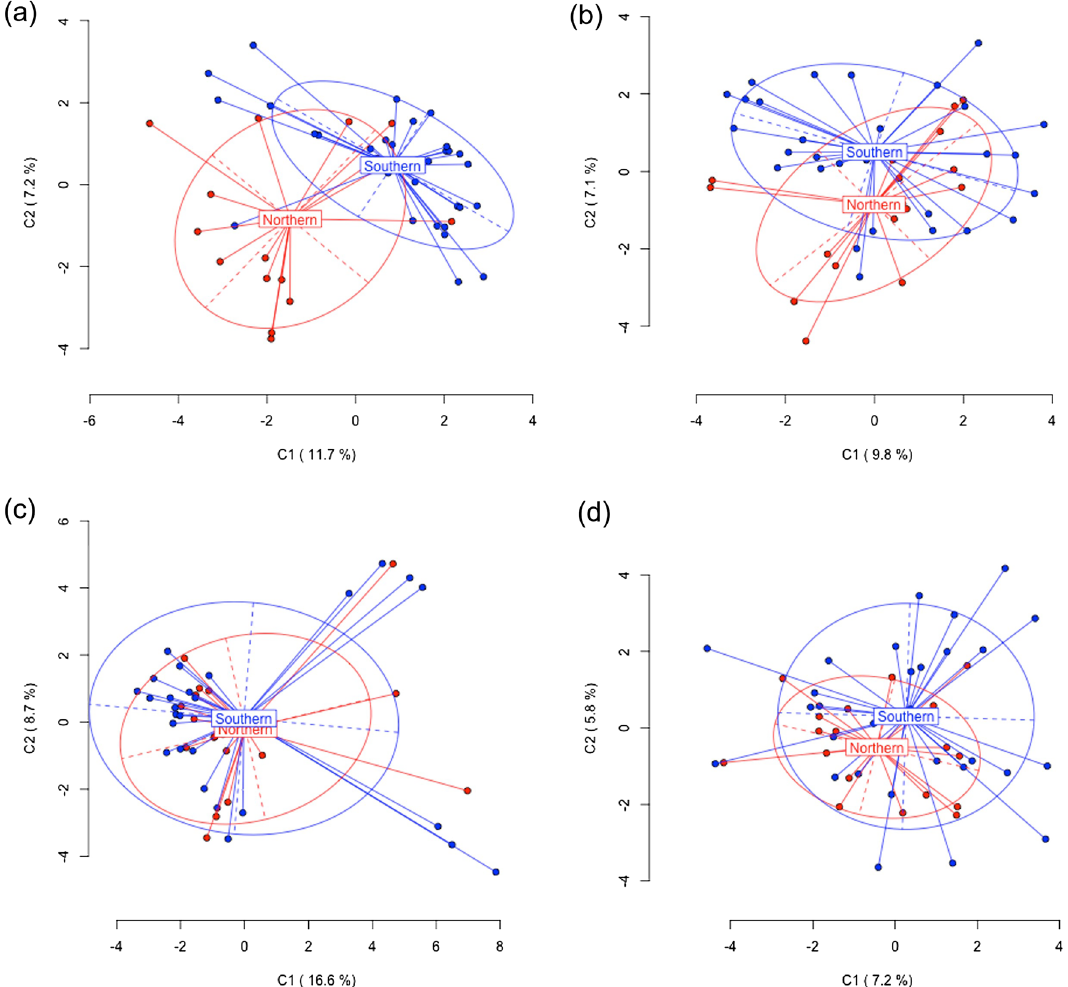
Figure 4. Results from principal coordinate analysis (PCoA) for epigenetic (MSL) of separated tissue (Muscle, Gonad, Gill) and eggs for the two regions (Southern and Northern), after AMOVA results based on hypothesis 2 (see “Material and methods”). The first two coordinates (C1 and C2) are displayed with the indication of the percentage of variance explained in brackets. Scores represent individual samples. Group labels show the centroid for each group (i.e. region). Ellipses represent the average dispersion of those points around the centroid. The long-dashed axis of the ellipse shows the direction of maximum dispersion, and the short-dashed axis shows the direction of minimum dispersion. ( a ) Eggs; ( b ) Gonad; ( c ) Muscle; ( d ) sites, different studies have shown that macroalgae grow faster and attain larger biomass in association with the upwelling sites off Central Chile 28,29 . Moreover, kelp forests are resilient to nutrient loading from freshwater discharges and may experience enhanced productivity when stimulated by nitrogen runoff 37 . Therefore, food supply could be associated with this trend of potential increasing eggs lipid metabolism along the study area. Tissues displayed different levels of DNA methylation when all individuals within the same population were pooled, suggesting that individual (within-population) variability plays an important role in shaping the popula- tion epigenetic profiles of all tissues (including eggs) of T. dentatus . Using the MSAP technique, tissue-specific differences in DNA methylation have been recorded in scallops 45 , although with smaller variation within the tis- sue (20.5–21.4%) compared to the present study (roughly from 30 to 45%). The gill was presented with the highest individual variability, followed by gonads and muscles. This tissue-specific epigenetic difference could be due to the tissue turnover and to the differential spatial–temporal scales at which tissues are exposed and respond to environmental fluctuations during an individual lifetime 46 . Feinberg and Irizarry 47 , using an inherited stochastic variation model, suggested that epigenetic variation can increase in fluctuating environments. Our observations of higher individual variability in tissues that are potentially linked to increased fluctuation in environmental variables agree with the prediction of the model. Such high variation in DNA methylation within populations was further confirmed by the low variation among populations (with a slight exception for the eggs, see below), suggesting that local variability could be more important than large scale variation in environmental conditions or available resources which directly influence the DNA methylation of tissues.